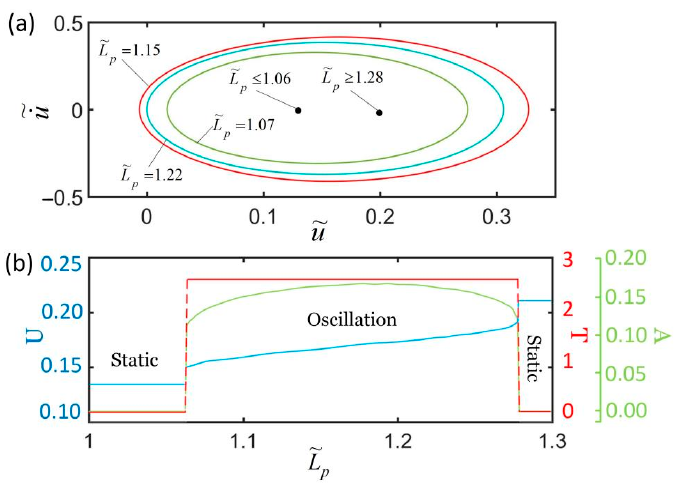
3.0~ = I Figure 9. The effect of painting stretch on self-excited oscillation for (cid:101) I = 0.3, (cid:101) k = 5.8, α = 0.35, (cid:101) g = 1.2,